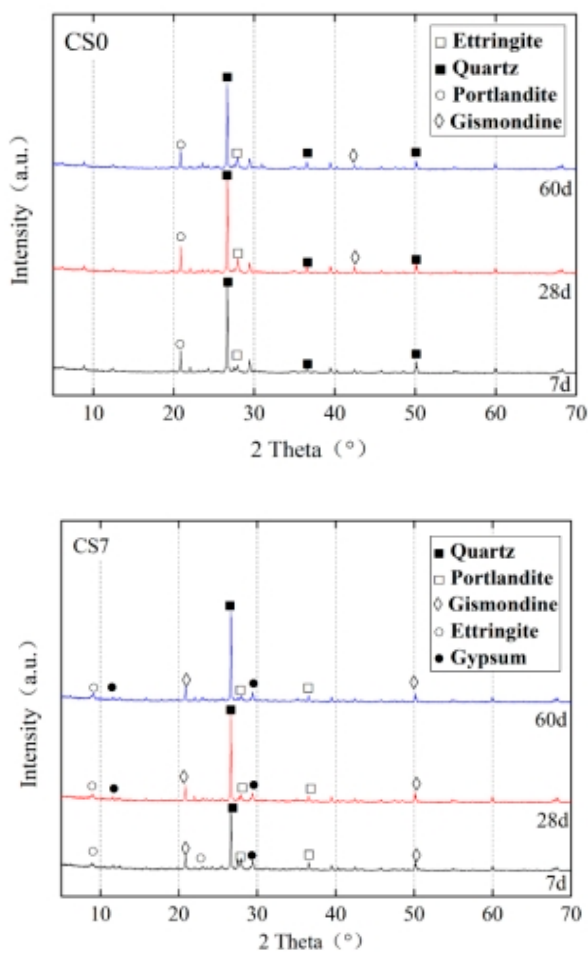
Figure 10. The XRD patterns of cement-stabilized clay (CS0) and cement–CFBS-stabilized clay (CS7).